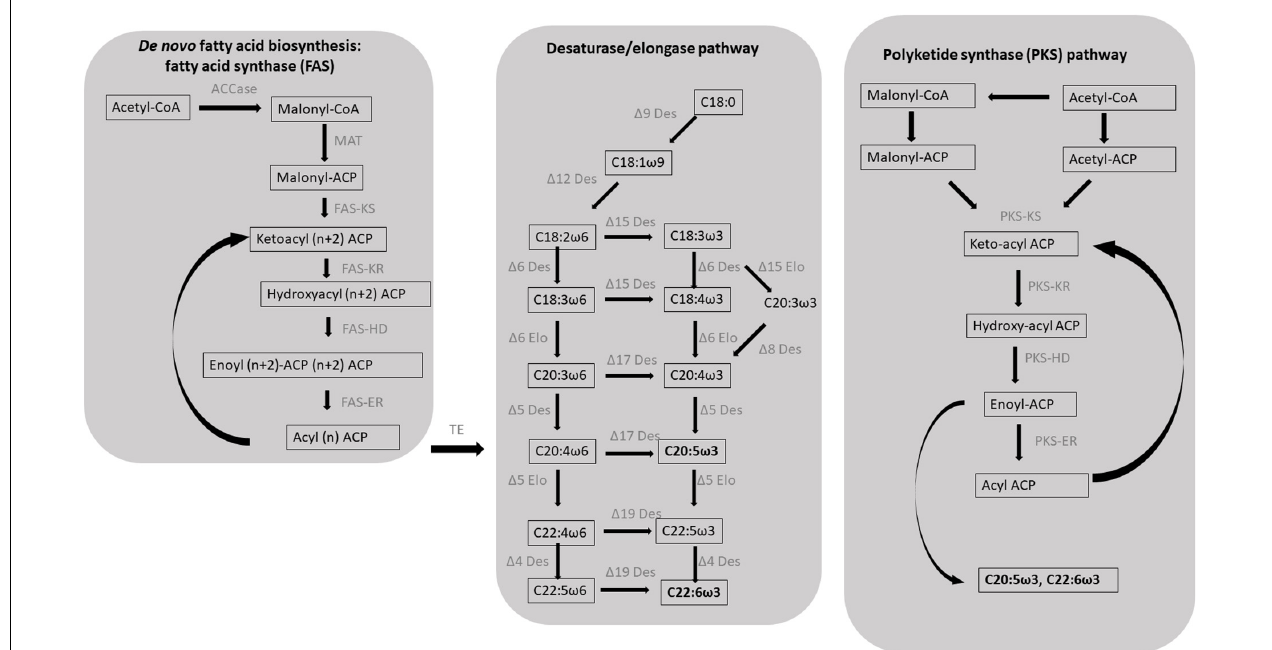
FIGURE 1 | Schematic diagram of the two major biosynthetic pathways leading to the formation of the eicosapentaenoic (EPA, C 20 : 5 ω 3) and docosahexaenoic (DHA, C 22 : 6 ω 3) in protists. EPA and DHA in microalgae typically result from de novo fatty acid synthesis followed by the desaturase/elongase pathways; an alternative pathway, in which double bonds result from incomplete elongation rather than desaturation, has been identified in a class of heterotrophic heterokonts known as thraustochytrids: the polyketide synthase (PKS) pathway. ACCase, acetyl-CoA carboxylase; ACP, acyl carrier protein; MAT, malonyl-CoA ACP transacylase; KS, β -ketoacyl-ACP synthase; KR, β -ketoacyl-ACP reductase; HD, β -hydroxyacyl-ACP dehydrase; ER, enoyl-ACP reductase; TE, acyl-ACP thioesterases; Des, desaturase; Elo, elongase. Figure modified from Hu et al. (2020) and Sun et al. (2018).